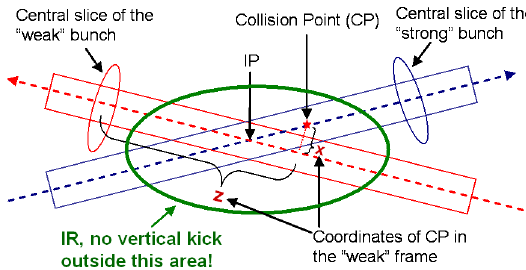
FIG. 13. Collision scheme with large (cid:8) (flat